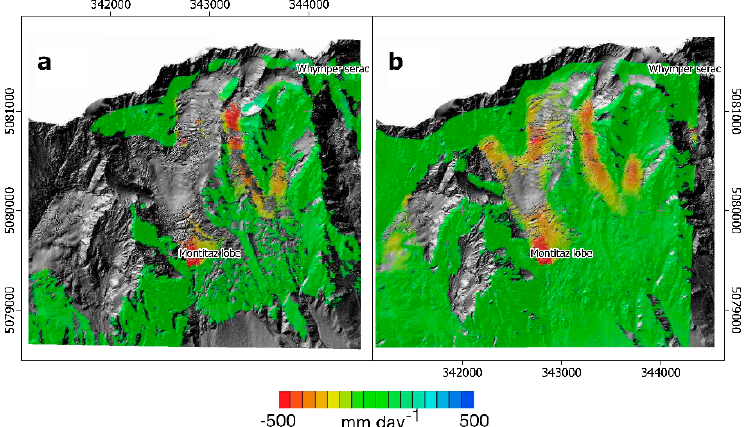
Figure 7. Velocity maps obtained with terrestrial interferometric radar installed ( a ) in the Planpincieux hamlet and ( b ) on the opposite ridge of the valley. The two campaigns lasted for 2 hours and were conducted on 7 and 8 August 2014, respectively. Modified from [47].